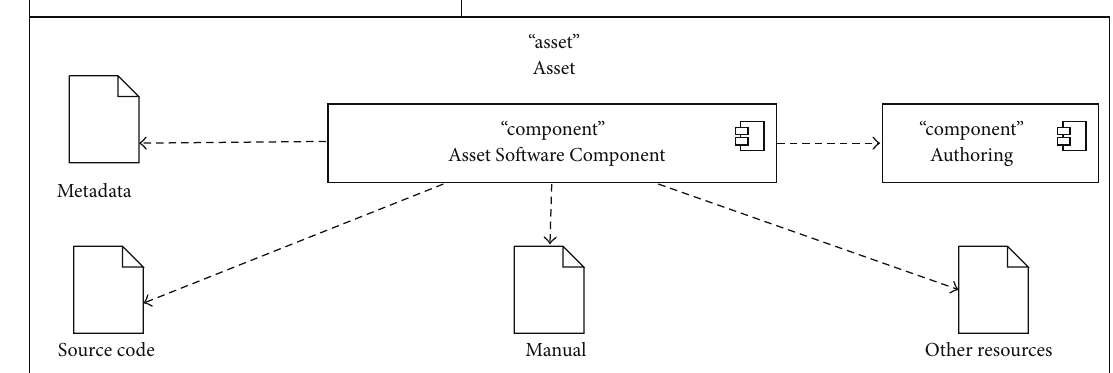
Figure 1: Exemplary layout of a RAGE